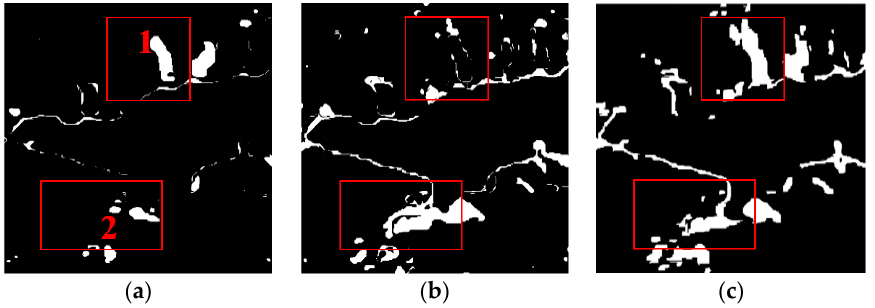
Figure 10. Change detection results ( a ) Between 2011 and 2015 using the OT_GSRM_GGMM. ( b ) Between 2011 and 2016 using the OT_GSRM_GGMM. ( c ) Between 2015 and 2016 using the OT_GSRM_GGMM.